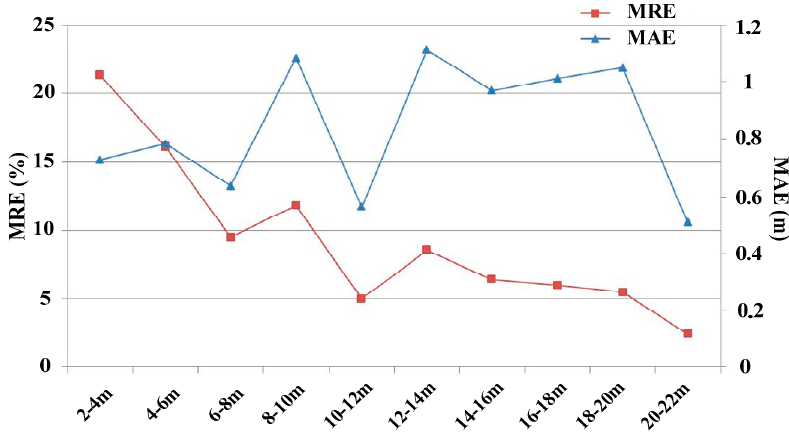
Figure 14. MAE and MRE of specific depth ranges of validation points.